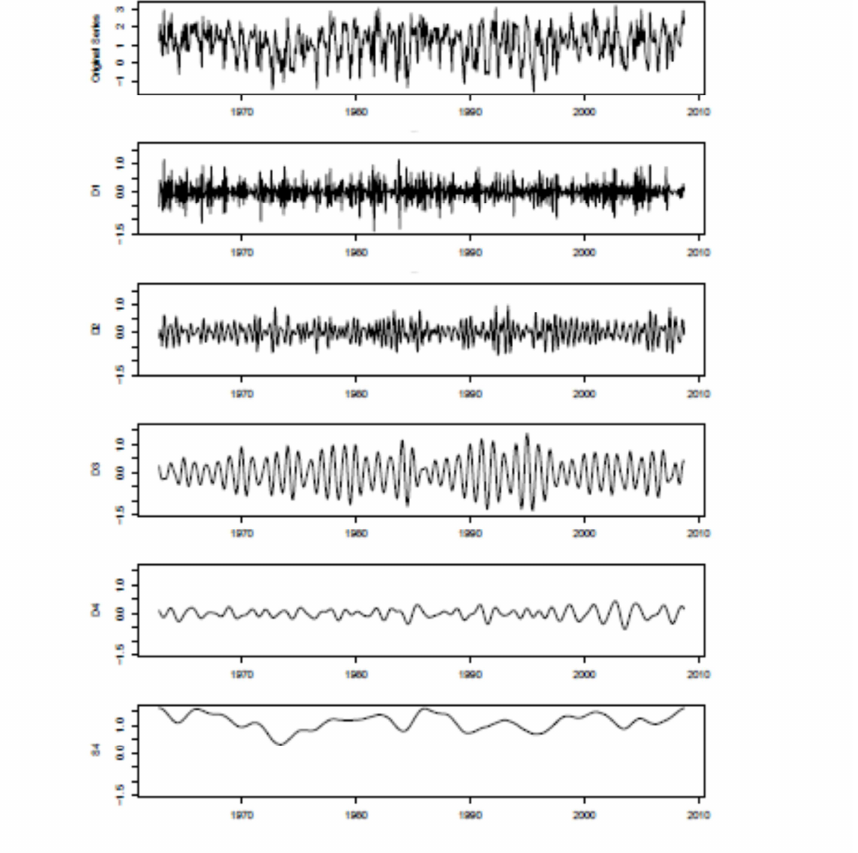
Figure 4 – Wavelet decomposition of river Tweed flow data (Franco Villoria,